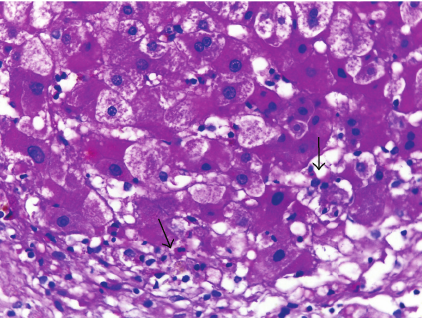
Figure 4: Focal acinar collapse. Sinusoidal inflammatory foci with some eosinophils. Hepatocyte cytoplasmic cholestasis, HE, 400x. See